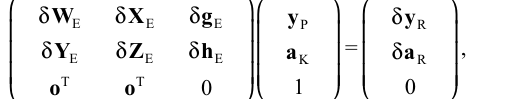
from a distant object with inclination a and we K K is the vector from the position R is measured from the R